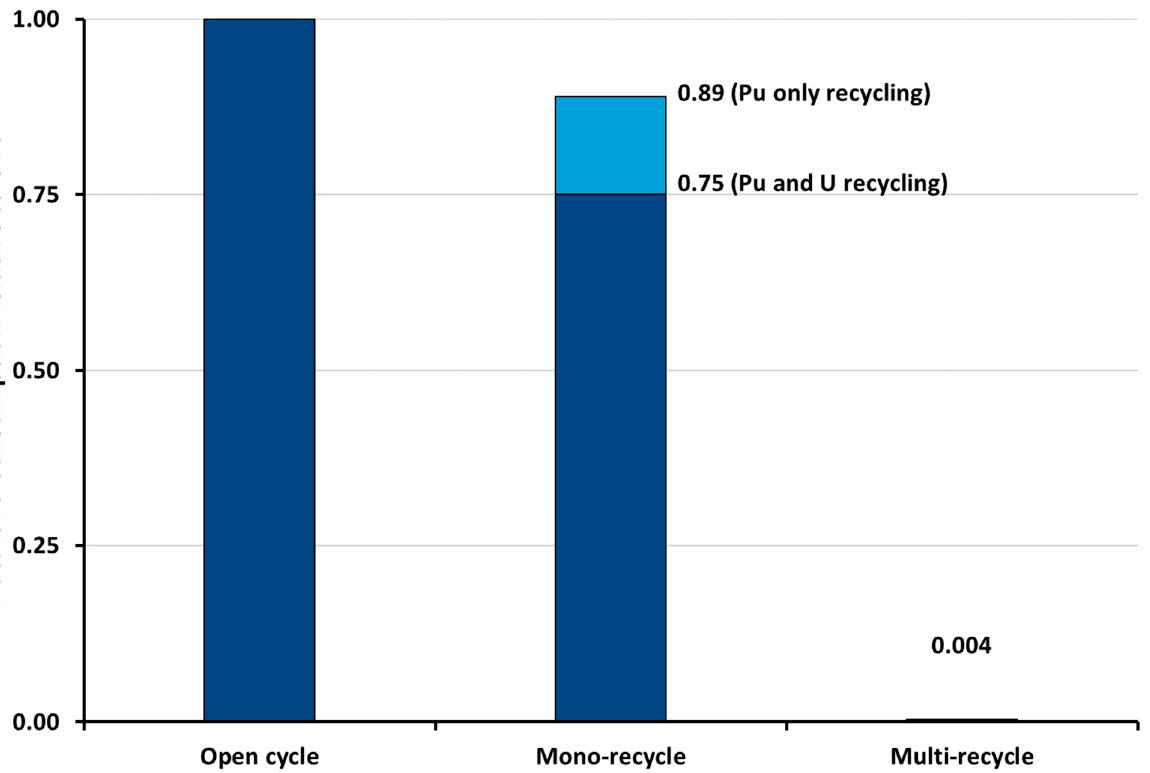
Two scenarios were modelled: the OTC and the closed cycle with a transition to fast reactors. The growth in nuclear energy is predicted to be strongest in IPCC ‐ 3 and IPCC ‐ 4, which overtake IPCC ‐ 2 in the second half of the 21st century. Uranium reserves are esti ‐ mated at 40 MtU (not including seawater), and Figure 5 illustrates the breakdown by re ‐ gion; interestingly, IPCC ‐ 3, which is predicted to have the strongest growth in nuclear energy, only contains ~5% of the reserves. Their predictions are that, with the OTC, con ‐ ventional resources will run out by 2100 and non ‐ conventional resources by 2150, with stresses on uranium appearing maybe a few decades earlier than 2100 due to the needs to ensure committed resources for the full lifetime of a reactor. A consequence of this is that the number of uranium mines is estimated to increase from ~15 in 2020 to ~80 by 2100 as